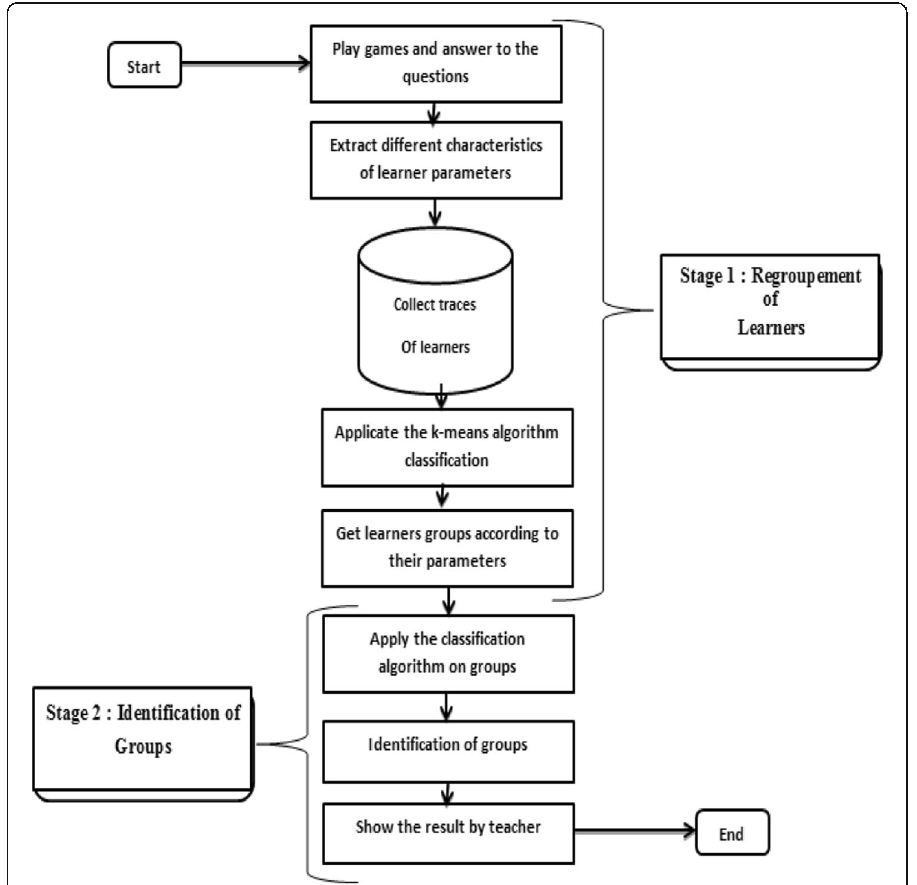
Fig. 2 Process of personalization strategy optimization in